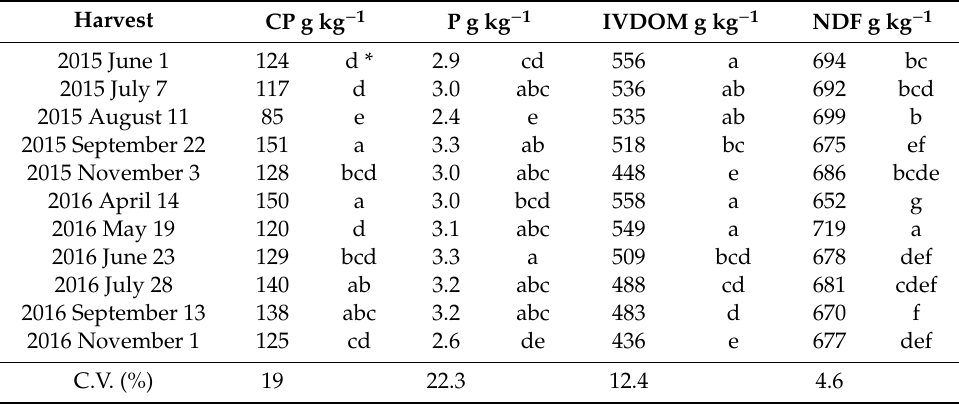
Table 5. Average nutritive value by harvest (11) for the selected population (15